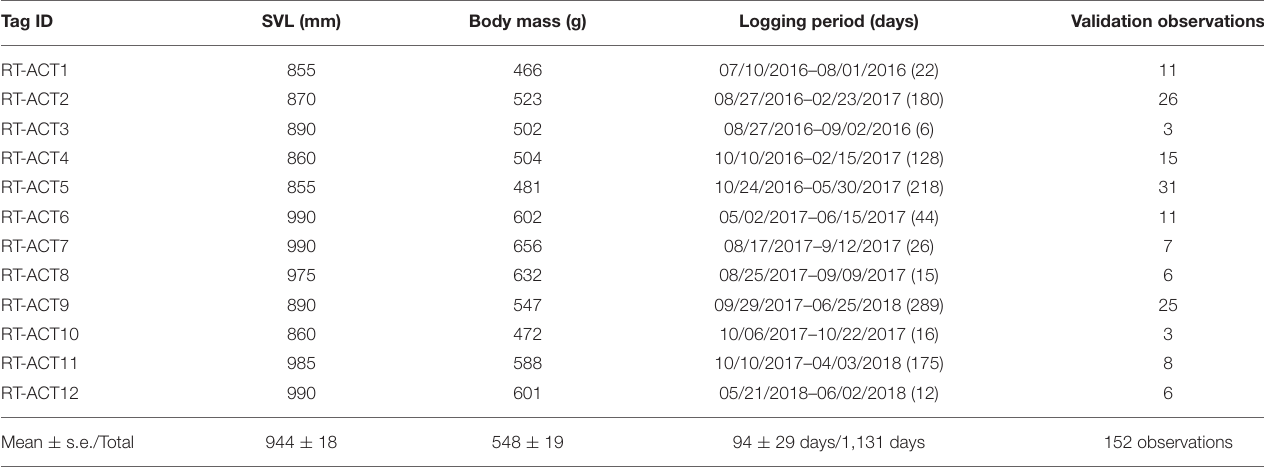
TABLE 1 | Body size [Snout-Vent Length (SVL), Body Mass], ACT logging periods, and number of field validation observations for 12 male C. atrox included in processing and analyses.